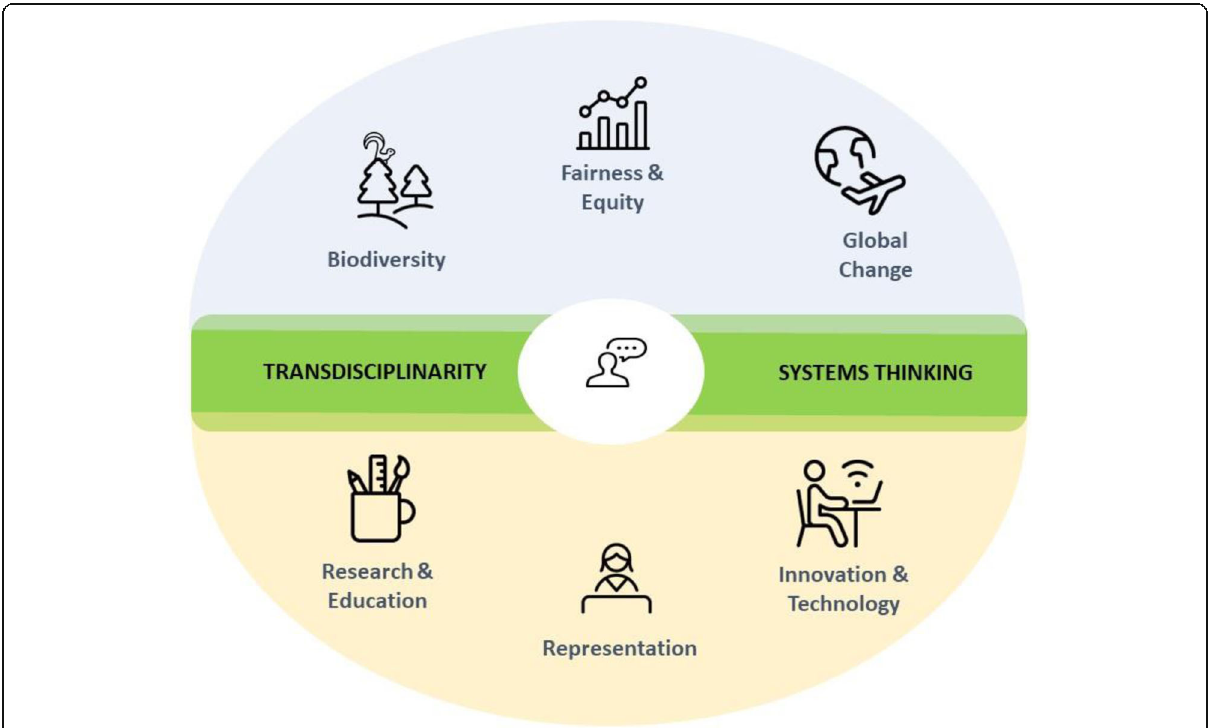
Fig. 1 Major themes emerging from international youth forums (UN Youth Climate Action Summit and UNESCO Man and Biosphere and CBD post-2131 forum) and the Global Shapers Survey by the World Economic Forum. The green band across the circle denotes two key concepts underpinning the six themes: transdisciplinarity and systems